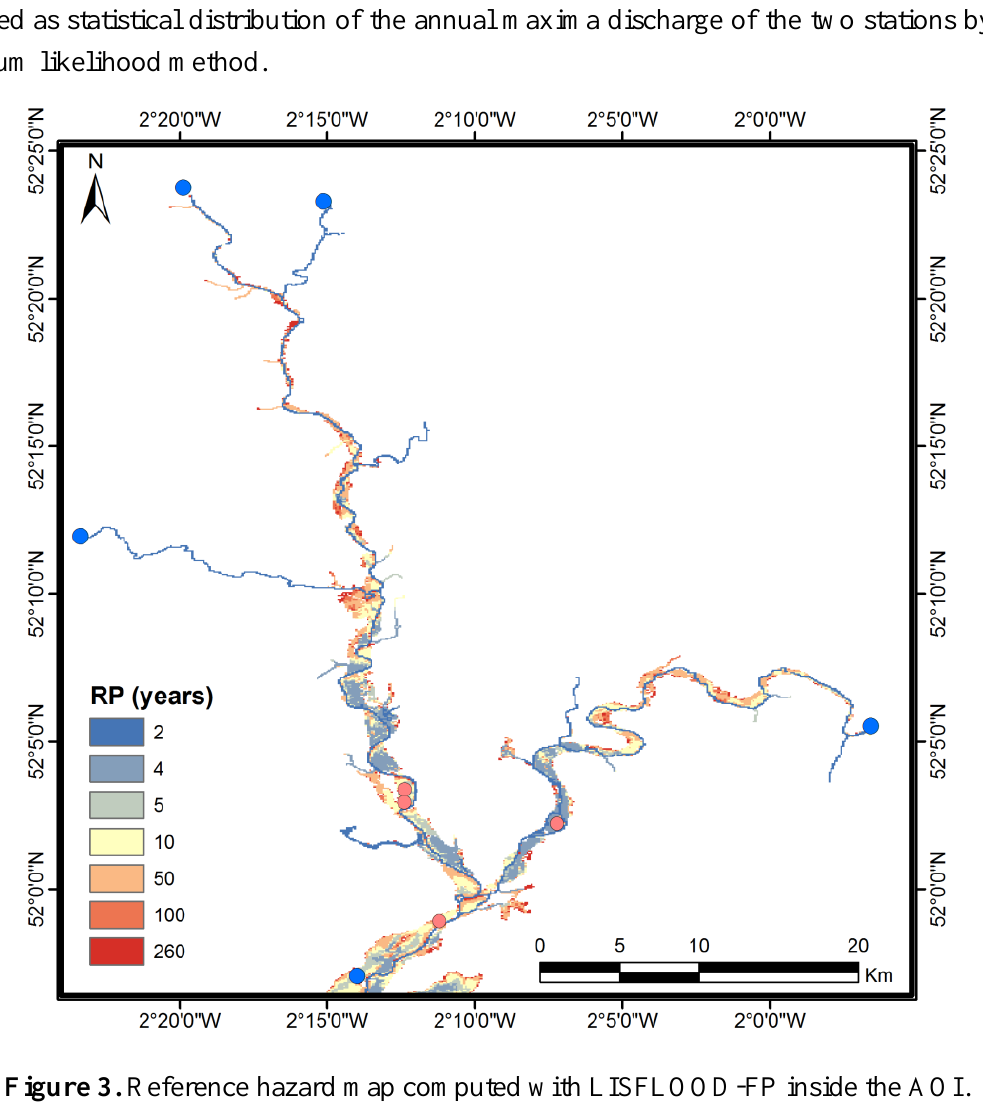
Figure 3. Reference hazard map computed with LISFLOOD-FP inside the